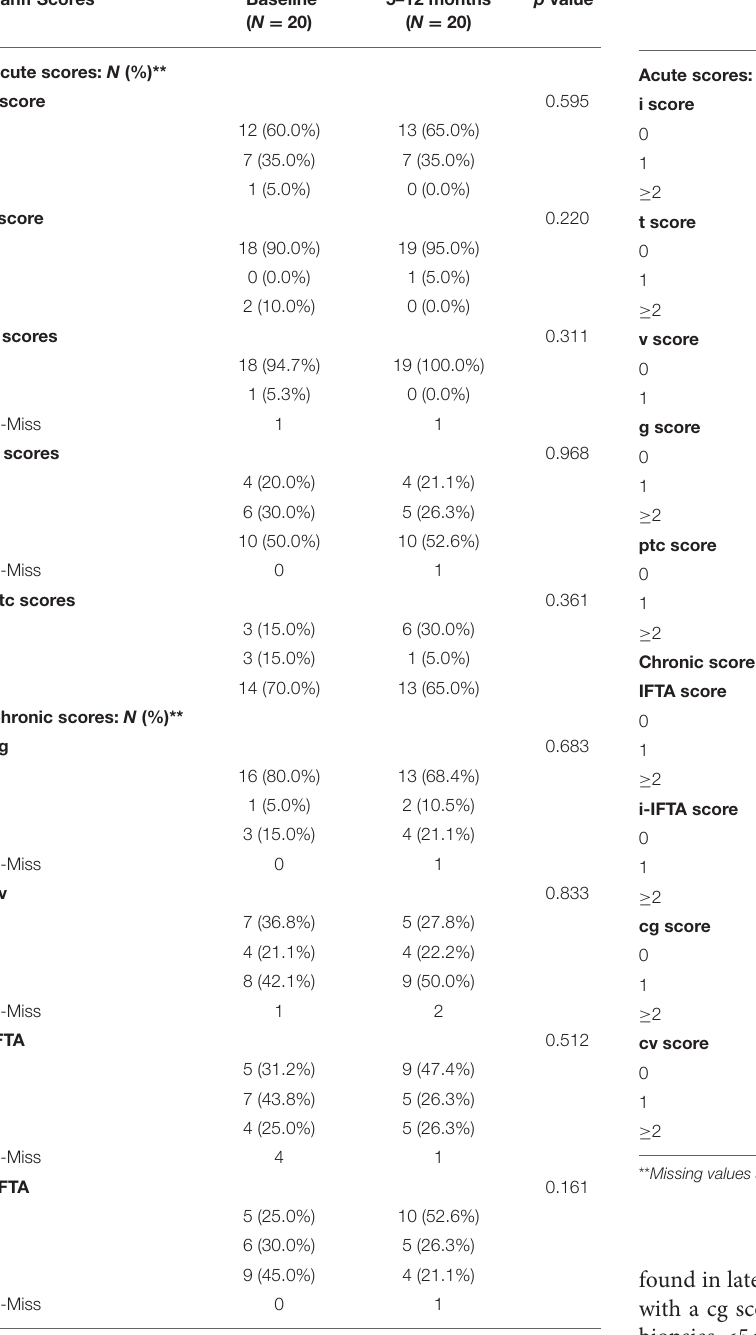
TABLE 3 | Histological Banff scores comparison post TCZ treatment for